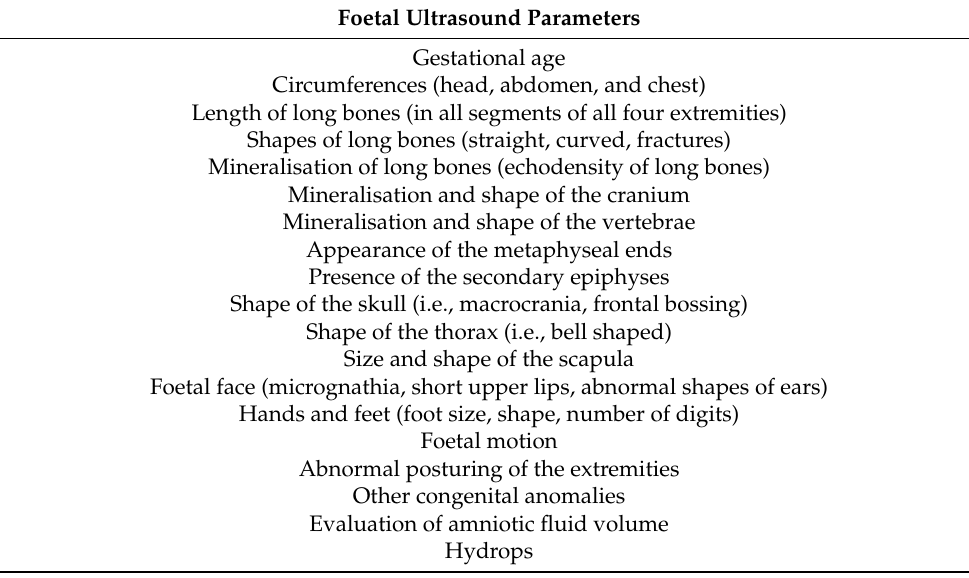
Table 1. Ultrasound parameters for foetal skeletal